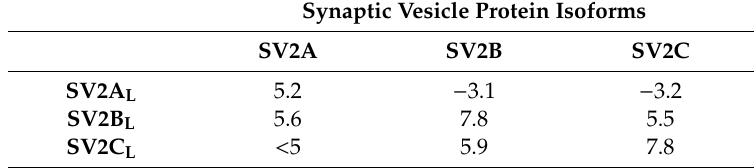
Table 1. pIC 50 of the competitors used for the different SV2 isoforms. Binding affinities measured for human SV2 proteins at 37 °C. Data are presented as mean (n = 3 to 10) from non-linear regression analysis of raw data using a sigmoidal dose-response model. Additional data for SV2B L (UCB5203) solubility: 0.1 mg/mL, route of administration: ip (suspension in 5% DMSO–1% methyl cellulose in